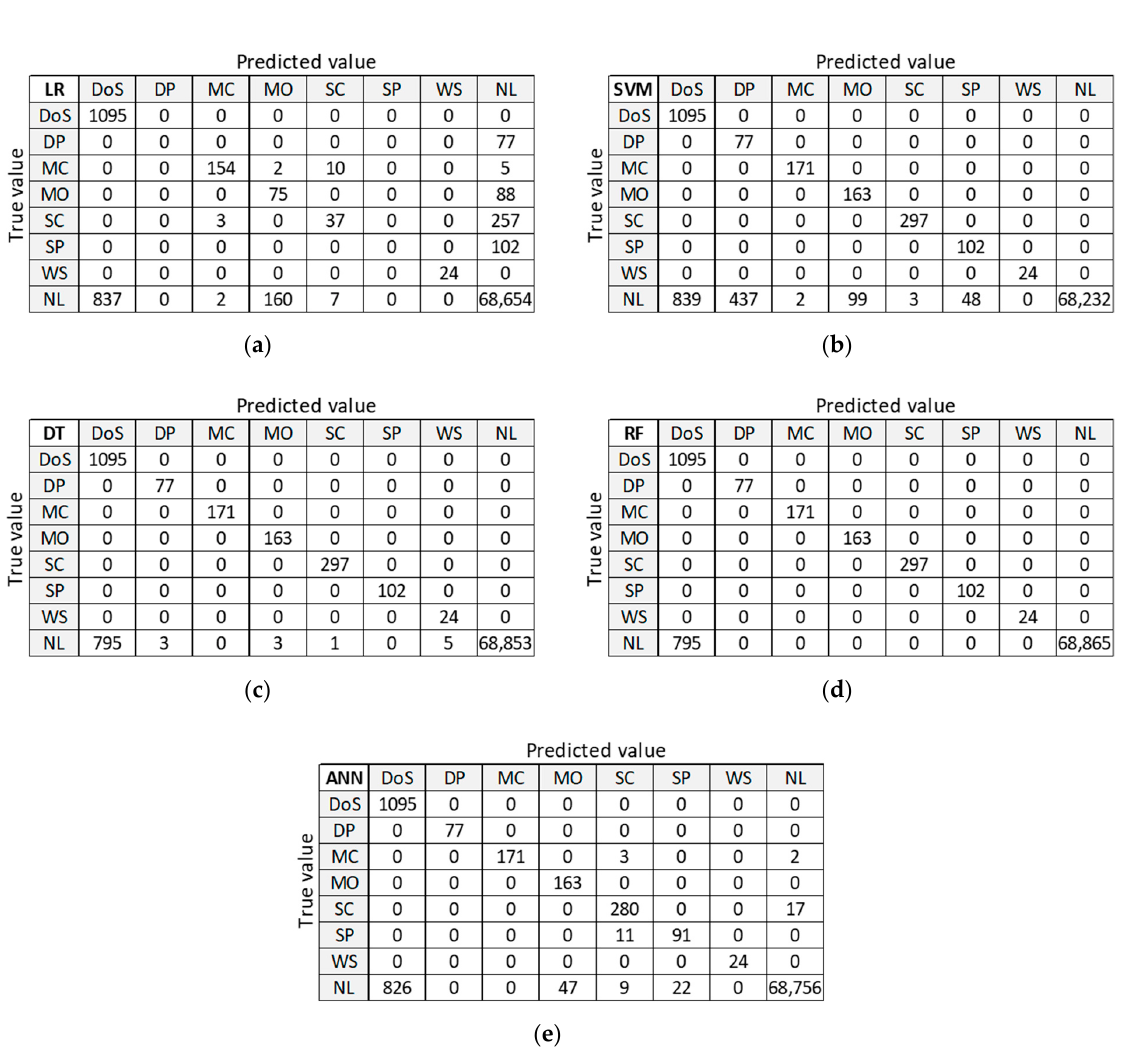
Figure 12. Confusion matrix on test dataset for training dataset DR5: ( a ) LR; ( b ) SVM; ( c ) DT; ( d ) RF; ( e ) ANN.